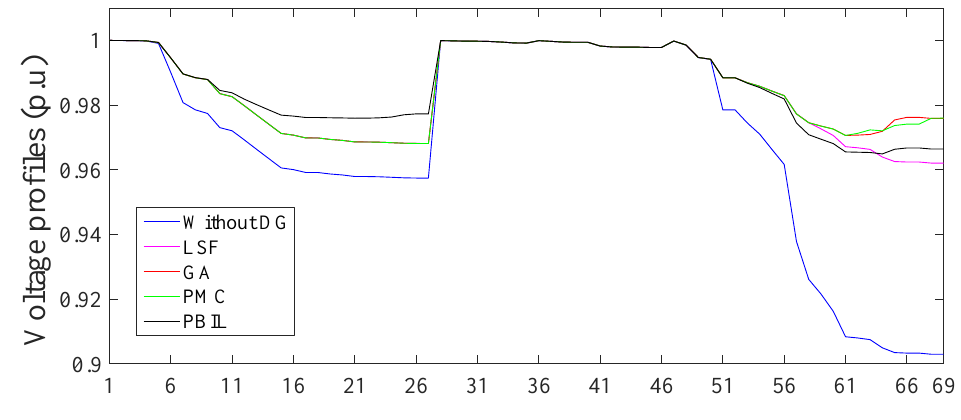
Figure 19. Voltage profiles of the test system with 69 buses.